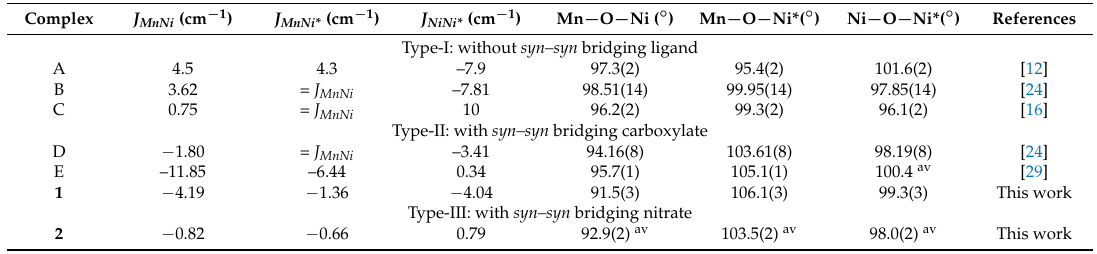
Table 2. Best fitting magnetic parameters and µ 3 -O bridging angles of 1 , 2 , and related complexes.